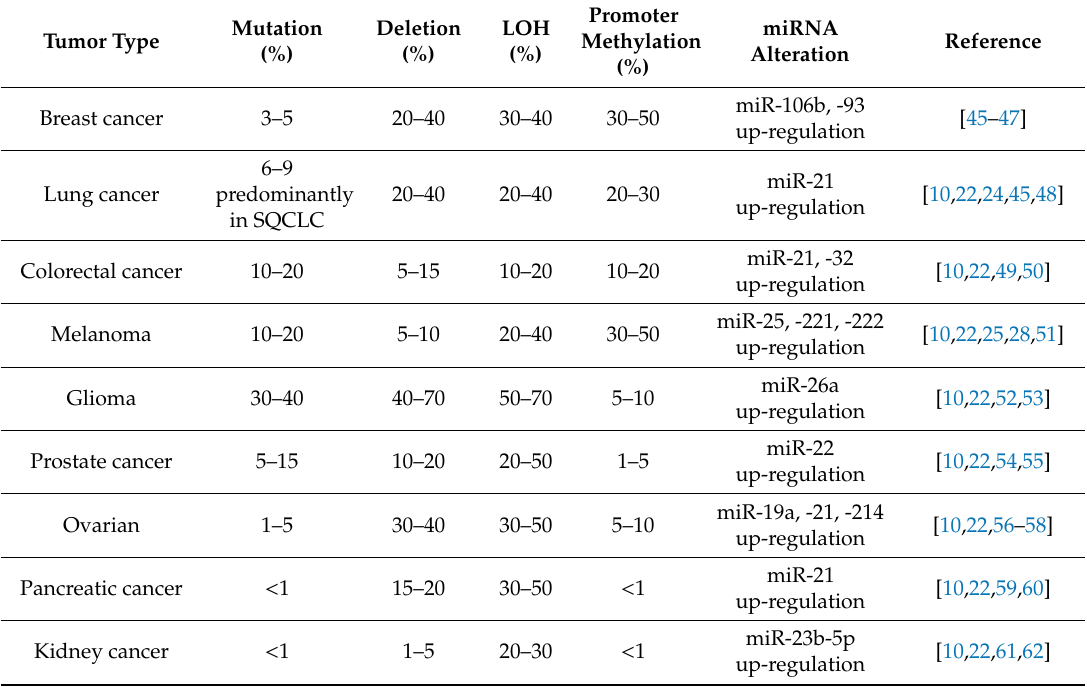
Table 1. Major structural genetic alterations of PTEN gene in solid